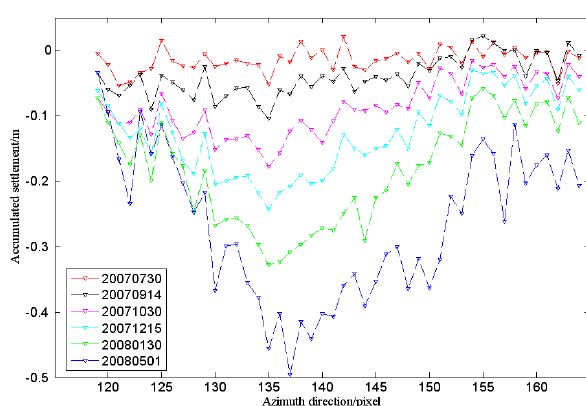
Figure5.Time series settlement profiles of subsidence funnel D in distance and azimuth direction Also funnel A and C area has been analyzed respectively, as shown in figure 4 and figure 5. The settlement of funnel C and funnel D area were continuous subsiding as times goes by, as funnel B area. But there was discontinuity of settlement in